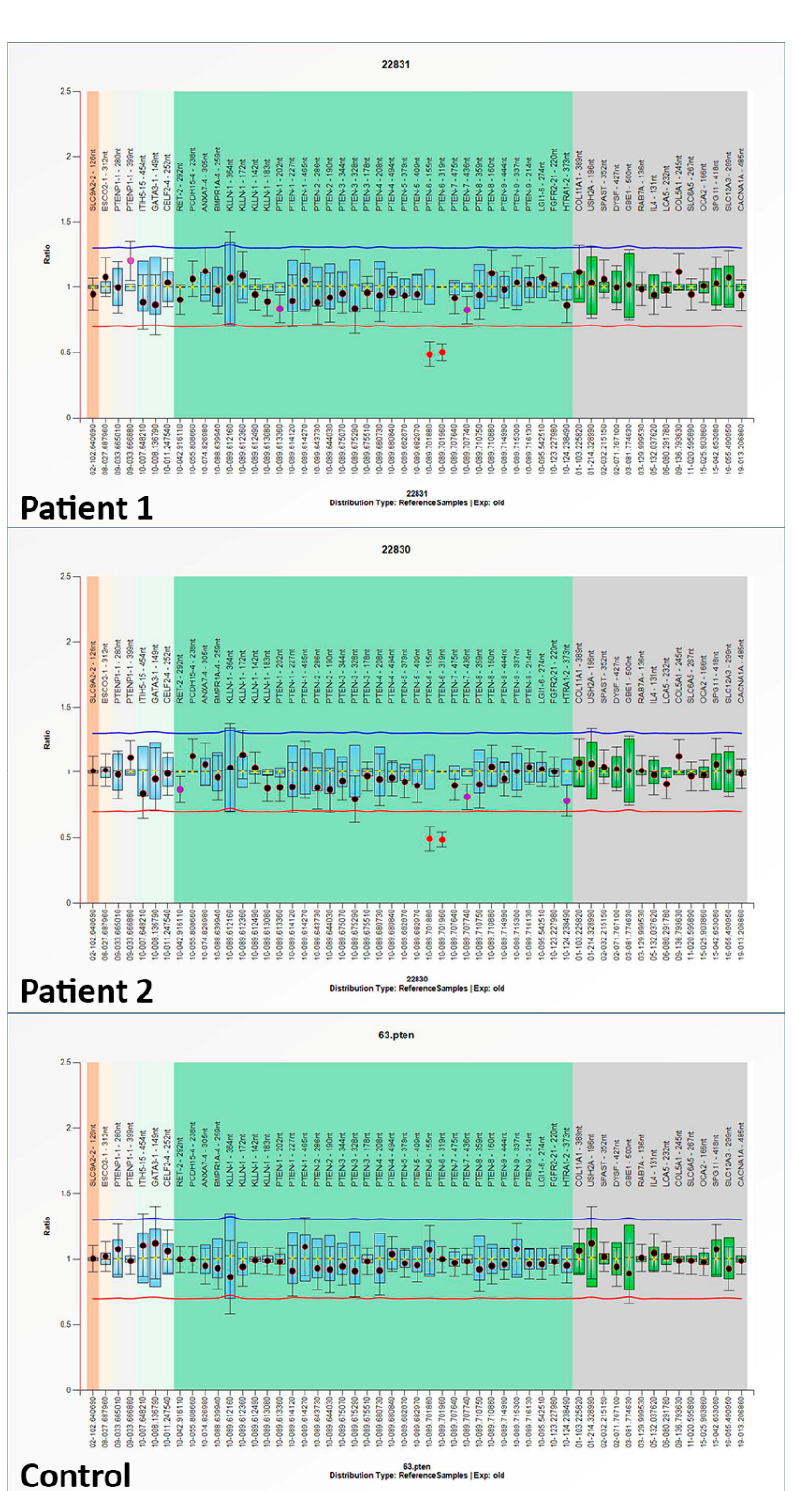
Figure 3. Genetic analysis revealing the same pathogenic variant in Patient 1 and 2. The MLPA analysis was conducted with Coffalyser software. The 95% confidence interval of a probe over the reference samples is depicted as a colored bar in the ratio chart. Both PTEN exon 6 in Patient 1 and in Patient 2 resulted under the arbitrary lower border (red line) which is set at 0.65 (0.95–0.3) and thus they are considered deleted in the samples. The blue line which is set at 1.25 (0.95 + 0.3) represents the upper arbitrary border. If a probe report crossed the latter boundary, this would be indicative of a